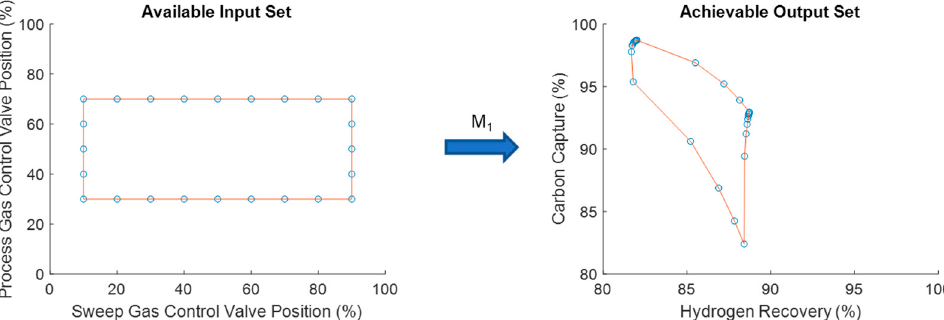
Figure 8. The mapping of the input space of control valve positions (AIS) to the output space of carbon capture and hydrogen recovery (AOS).